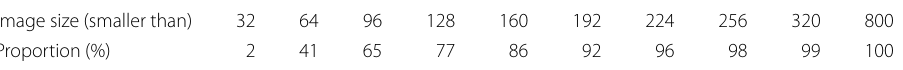
Table 1 Cumulative proportion of the extracted images of different sizes Image size (smaller